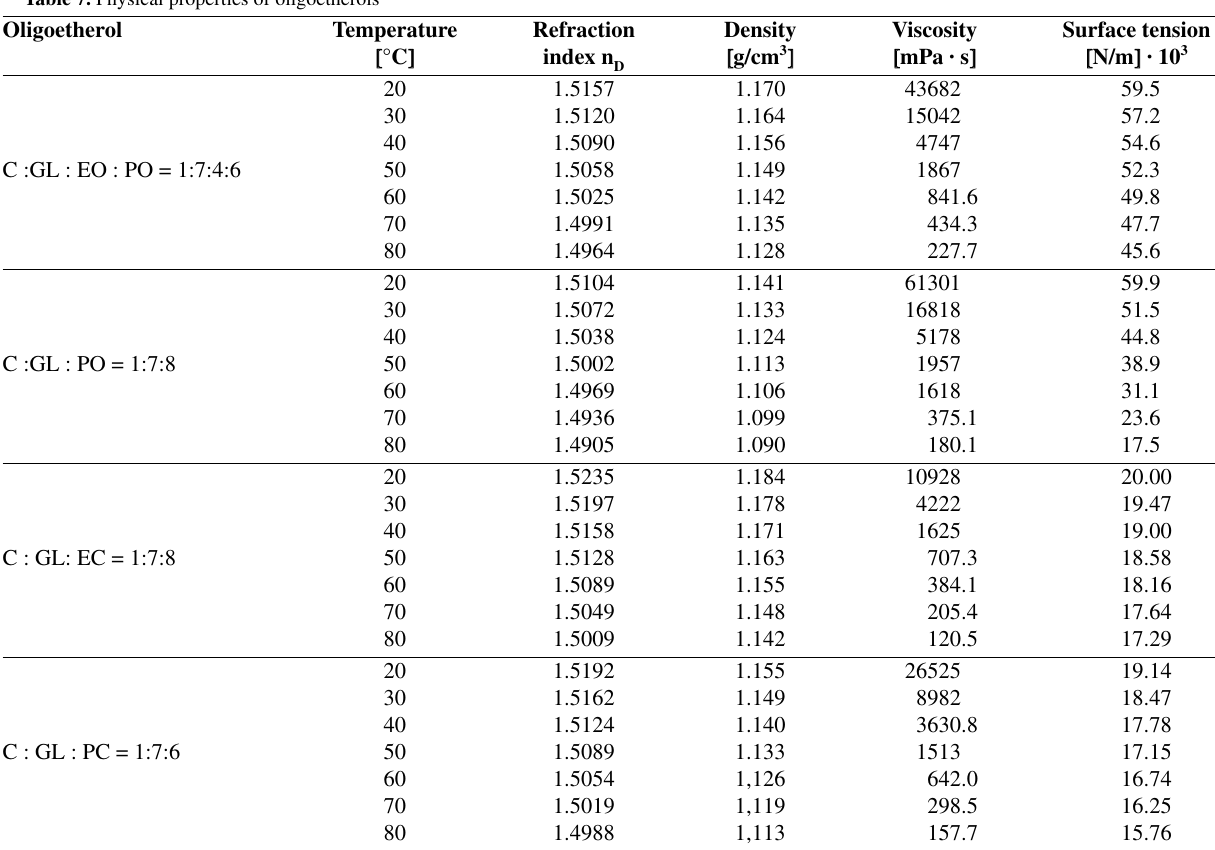
Table 7. Physical properties of oligoetherols